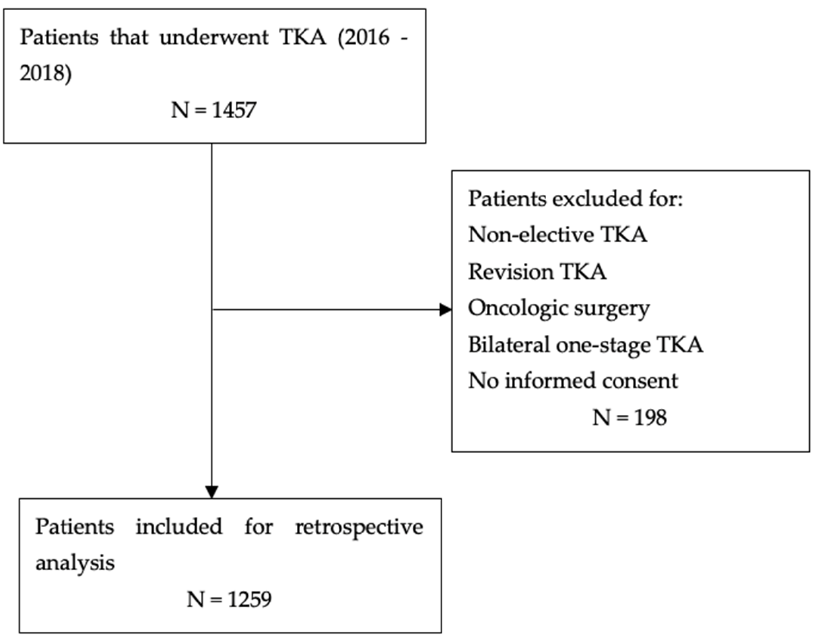
Figure 1. Medical records selection flow-diagram.